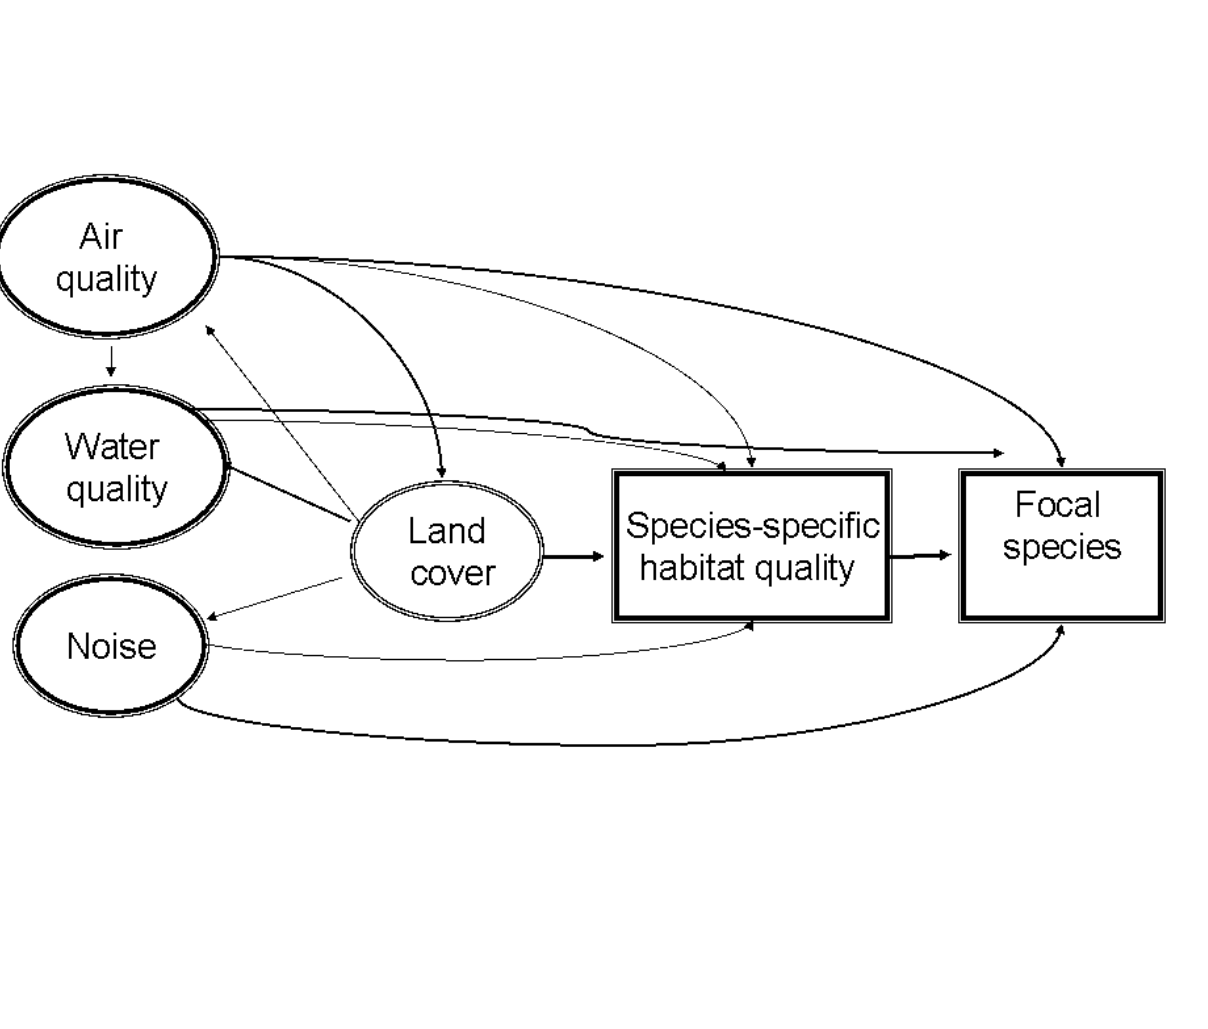
Fig. 2. Schematic diagram of the Regional Simulation